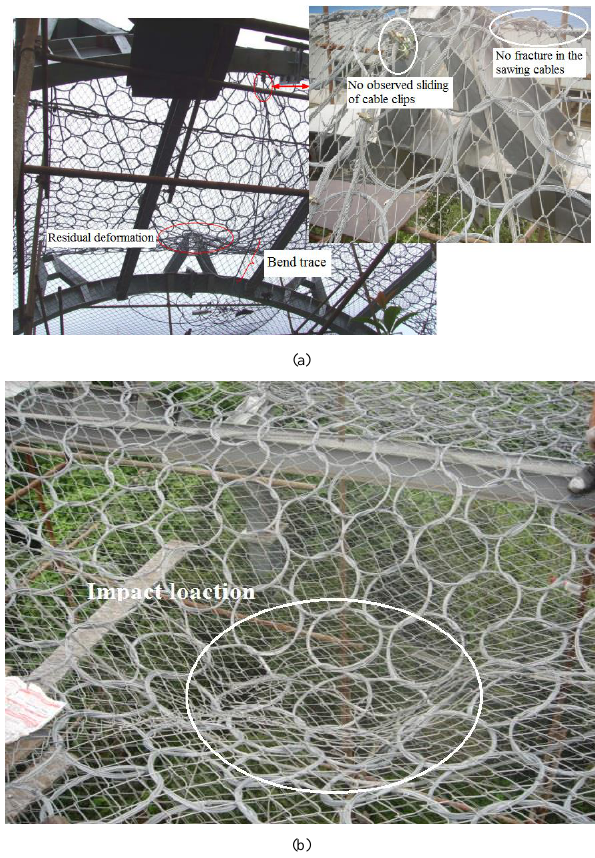
Fig. 10. The detail deformation of the components in the flexible rock-shed after the impact of the rock block.